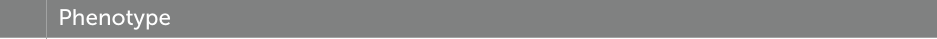
TABLE 1 Gene polymorphisms associated with